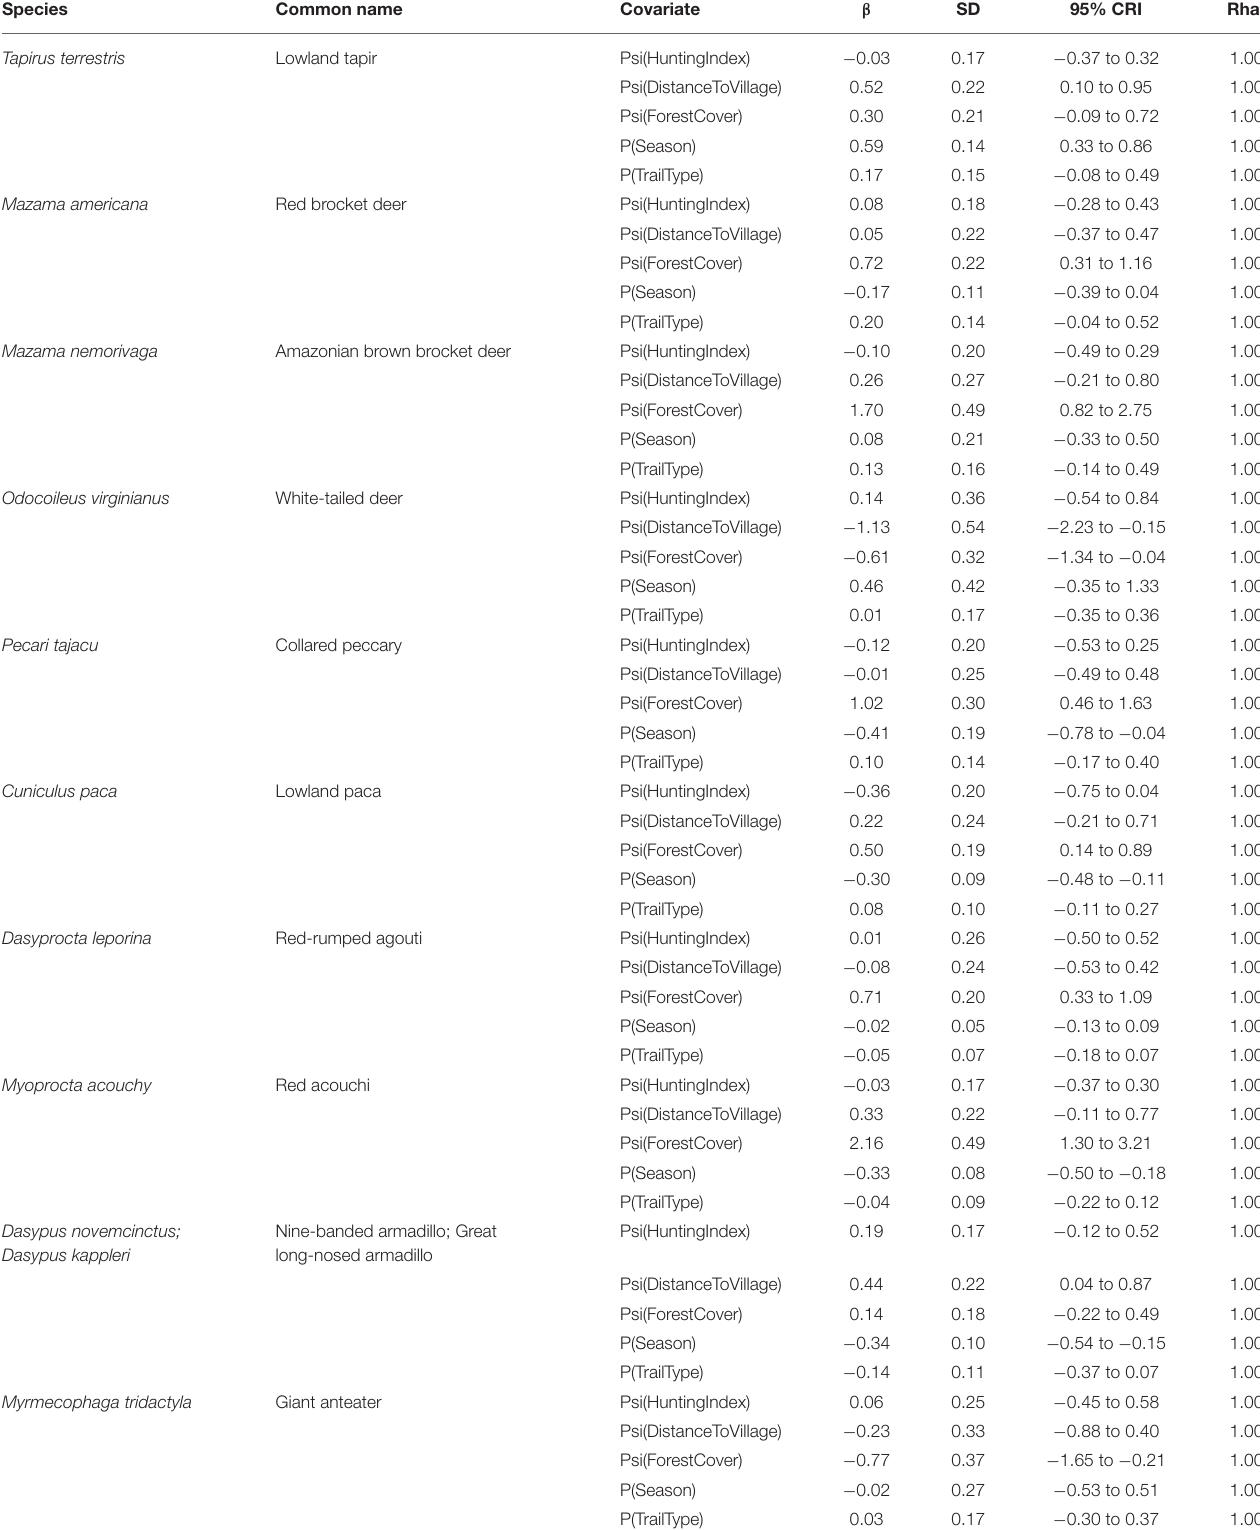
TABLE 3 | Species-specific summaries of covariate effects on occupancy (psi) and detection (p) for 18 species of interest. Species Tapirus